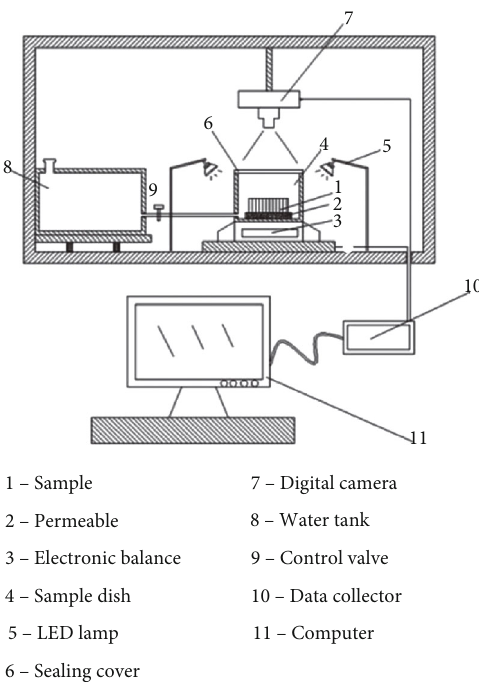
Figure 4: Test device of soft rock water absorption and cracking.